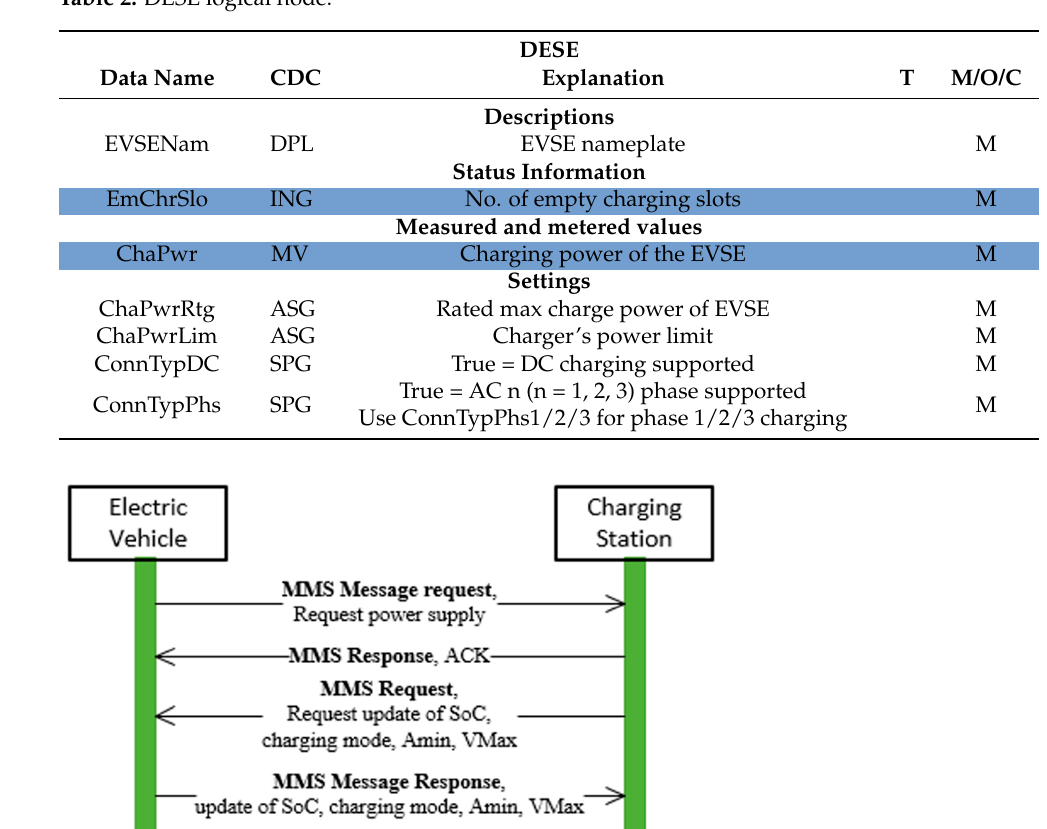
Table 2. DESE logical node.